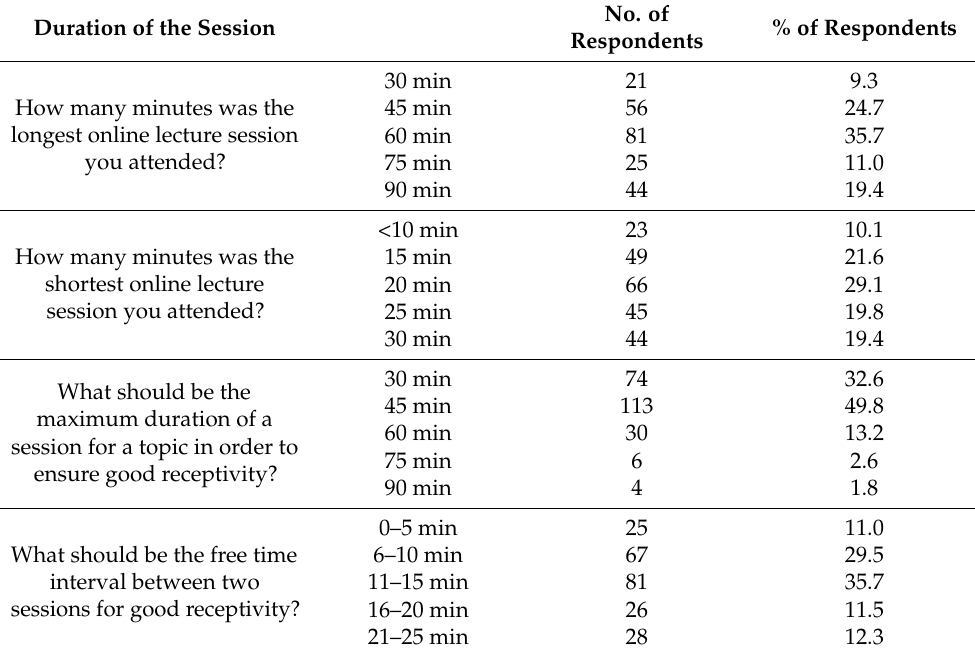
Table 2. Distribution of responses related to duration of the session.